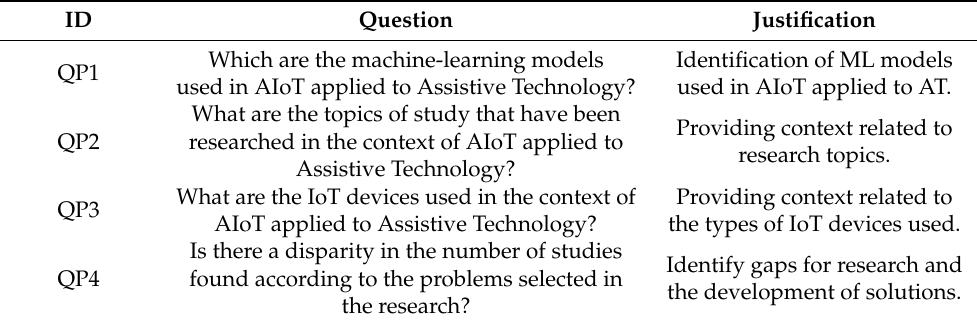
Figure 2. The systematic review model [80].